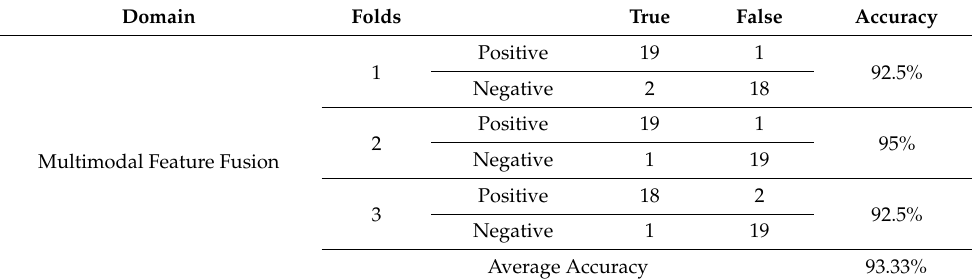
Table 8. Confusion